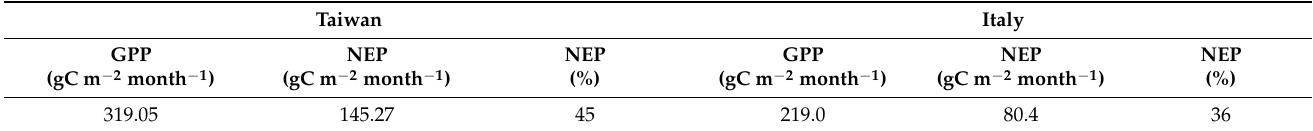
Table 3. GPP and NEP mean values in Taiwan and